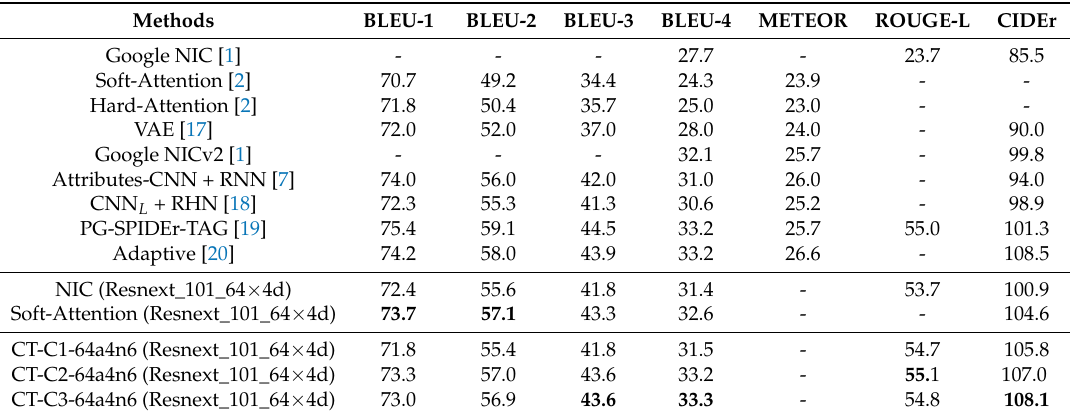
Table 1. The results of the Caption Transformer (CT) model compared with several state-of-the-art methods on standard evaluation